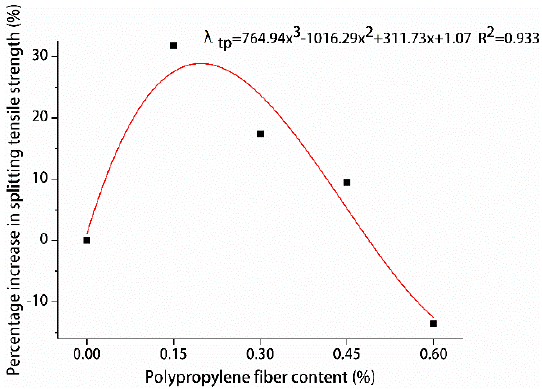
Figure 24. Relationship between splitting tensile strength and polypropylene fiber content.